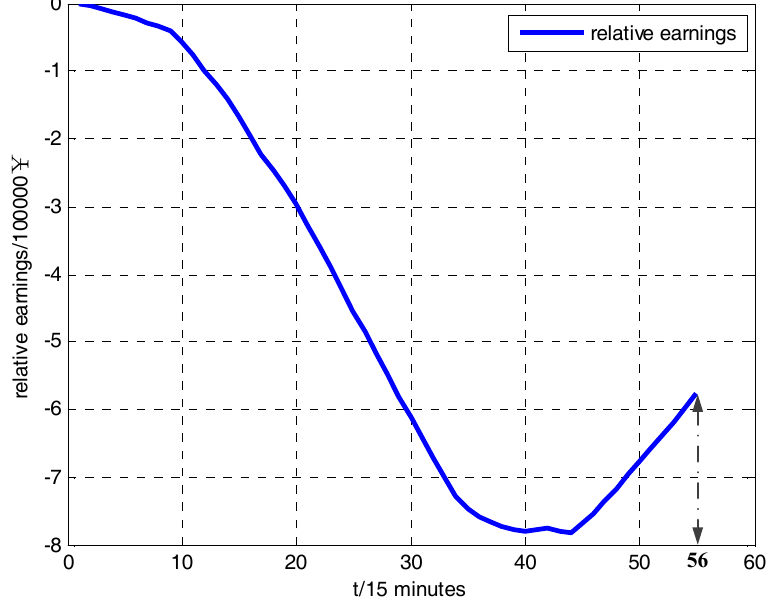
Figure 6. Diagram of the relative earnings of the next 14 h.